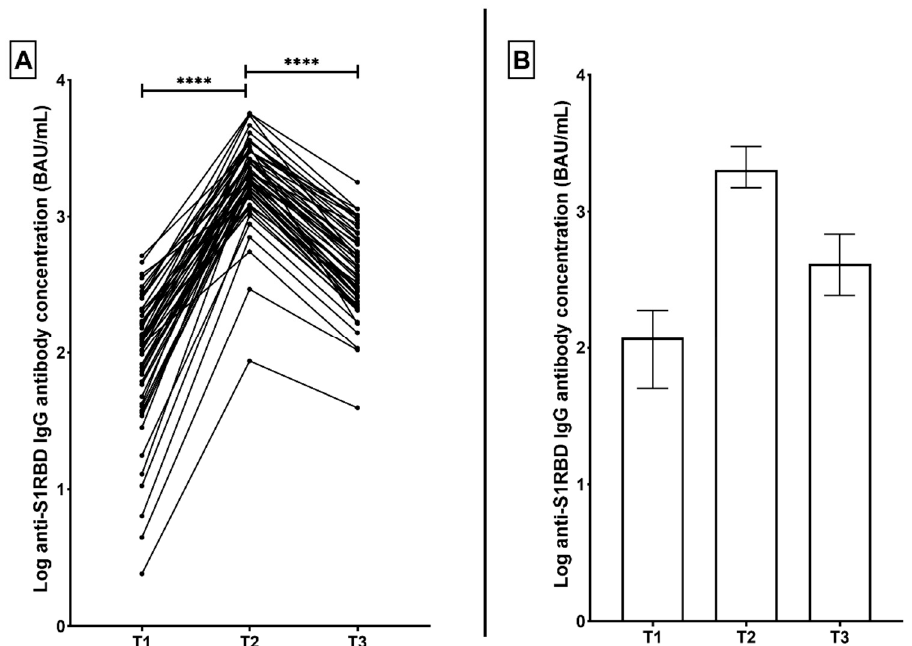
Figure 1. ( A ) Correlation graph representing the change in anti-S1RBD IgG antibody concentrations in BNT162b2 -vaccinated participants (PfVac) across three time points; 3 weeks after the first vaccination dose (T1), 3 weeks after the second dose (T2), and 3 months after the second dose (T3). ( B ) corresponding distribution graph with bars representing median and interquartile range. **** p < 0.0001.